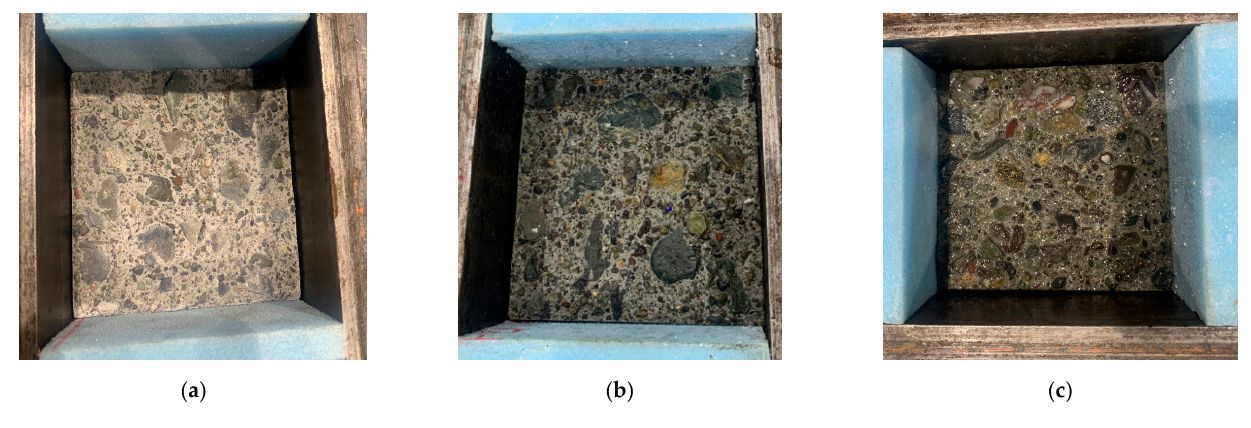
Figure 2. Moisture state of the interface used in this study. ( a ) AD, ( b ) SSD, ( c ) wet. Once the specimens were cast, the moulds were wrapped with a polythene sheet to avoid the evaporation of moisture. Twenty-four hours after casting, all the formworks were demoulded, and the specimens were cured in water for 7 days to help the hydration process followed by dry curing for 21 days. Curing under dry conditions benefits the formation of polymer films that can fill the voids and strengthen the PCM [39]. The total number of composite specimens cast for this study is shown in Table 4. The acronym designations adopted for each group of specimens are as follows: the first letter “N” or “M” refers to normal or modified 5% silica PCM, followed by test type (single surface shear test (A) or bi-surface shear test (B), roughness level of the interface (S or R) and moisture state of the interface (SSD, AD, or wet). For example, NA_R_SSD refers to a composite specimen with normal PCM tested under direct single surface shear which was bonded by rough interface with moisture state of saturated surface dry condition of the interface.